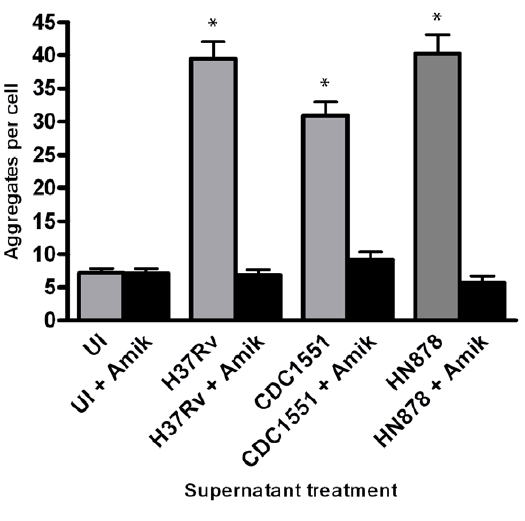
Figure 6. Proteins secreted by live Mtb bacilli induce LR aggregation in alveolar epithelial cells. A549 cells were infected with CDC1551, HN878 and H37Rv that were either pretreated with amikacin or untreated at MOI 100 for 24 hr. Supernatants were then micro-filtered and applied to fresh monolayers of A549 cells seeded onto coverslips and allowed to incubate for 24 hr. Coverslips were prepared for confocal microscopy as described. Supernatants from infections with untreated bacteria produced significantly more LR aggregation compared to supernatants from infections with amikacin- treated bacteria (*p-value , 0.001). Infections and subsequent super- natant treatments were performed in duplicate and repeated twice. A total of 15 fields were imaged per coverslip, incorporating approxi- mately 30–50 host cells per field. Images to analyze LR aggregation were captured at 63x magnification. (UI=uninfected cells; Amik=su- pernatants from bacteria pretreated with Amikacin).